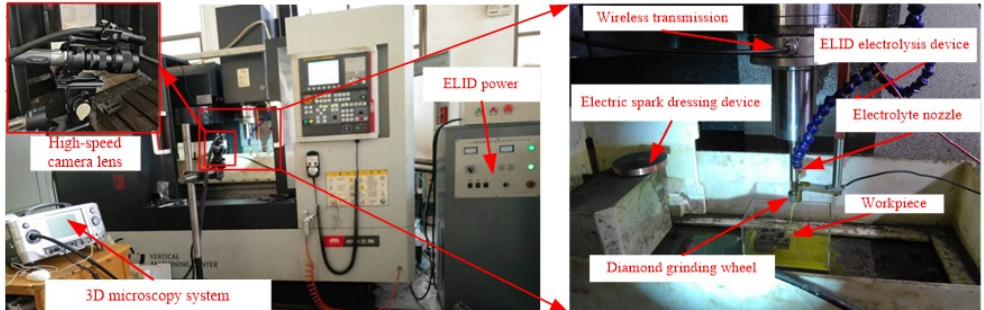
Figure 6. Experimental setup for UA-ELID grinding. Table 1. Relevant parameters during